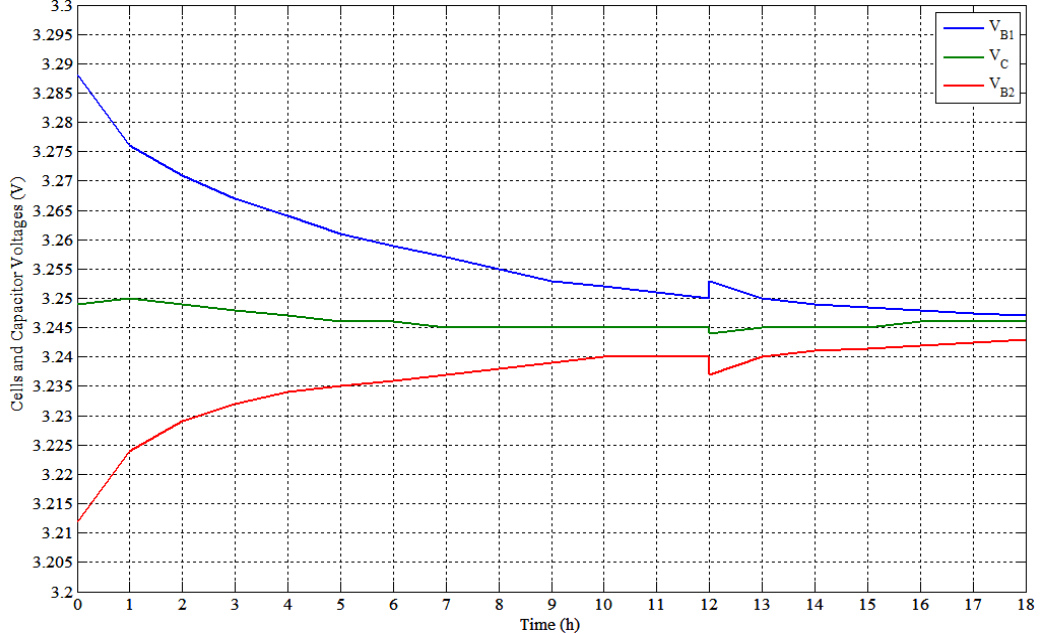
Figure 29. Experimental results of 2.3 A·h cells with SSC balancing (Test No.